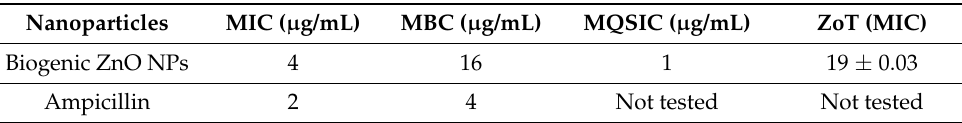
Table 2. Results displaying values of MIC, MBC, MQSIC, and zone of turbidity (ZoT) in mm for the biogenic ZnO NPs against C. violaceum